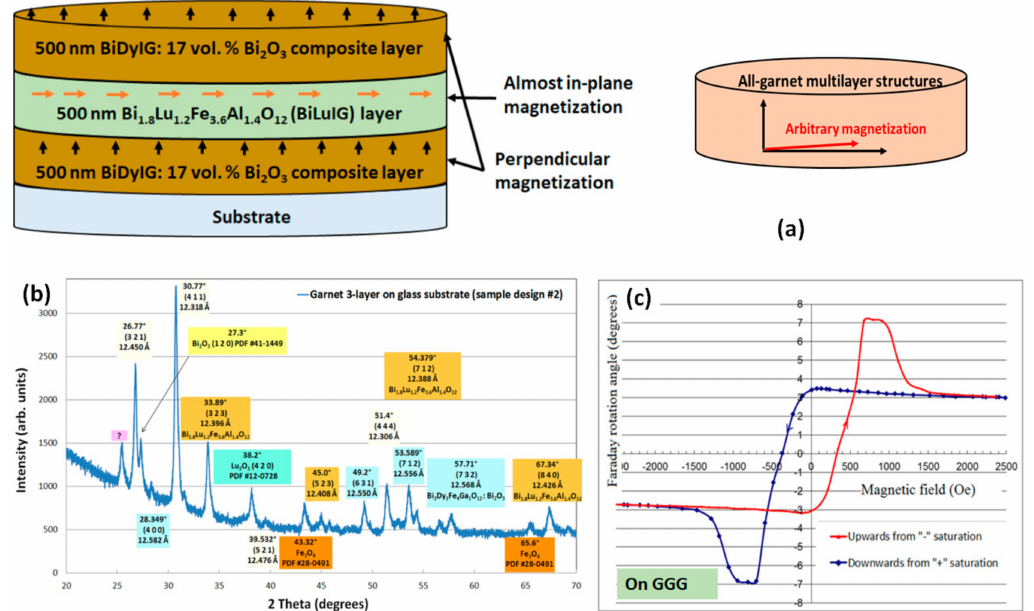
Figure 4. The schematic diagram of all-garnet multilayer structures together with the predicted layer-specific magnetization vector directions ( a ); XRD analysis results obtained from a multilayer garnet structure prepared on a glass substrate ( b ); the unconventional magnetic hysteresis loop of Faraday rotation ( ◦ ) measured using green laser light source ( c